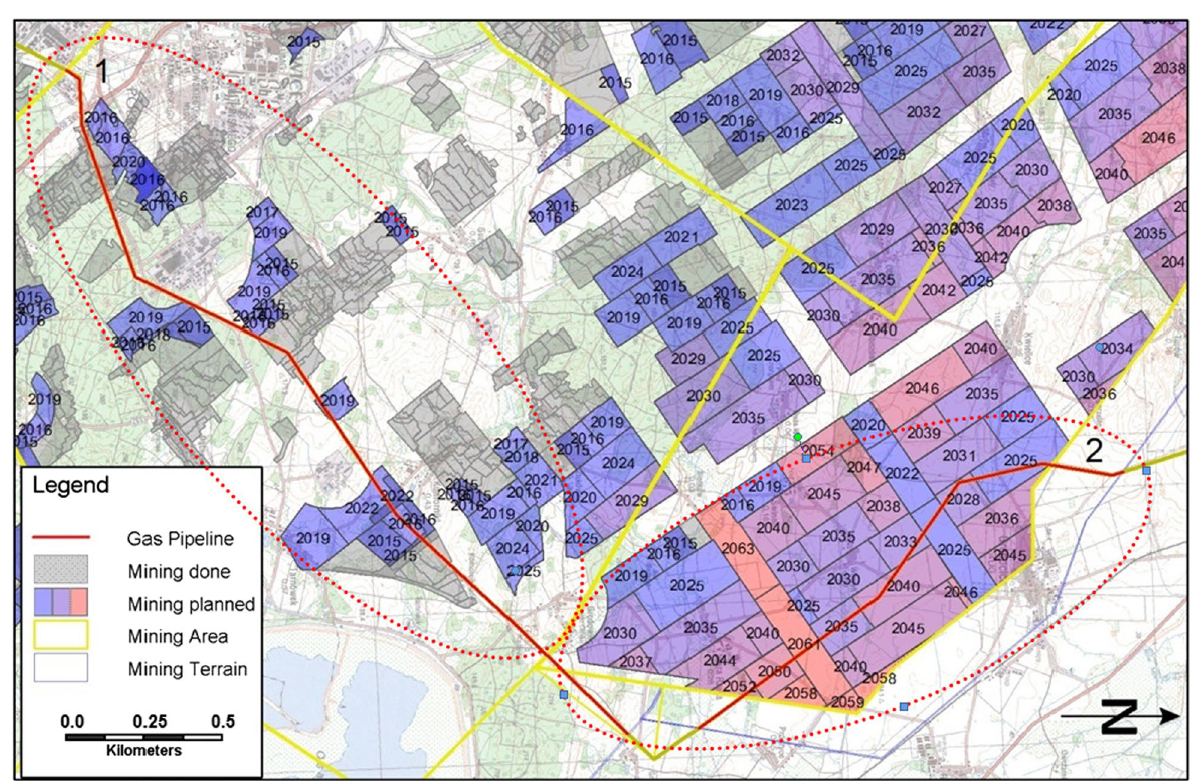
Fig. 1 Placement of the planned gas pipeline, the gas pipeline is marked with the red color, the mining which was finished is marked as a polygon in a grey color, mining which was planed is marked